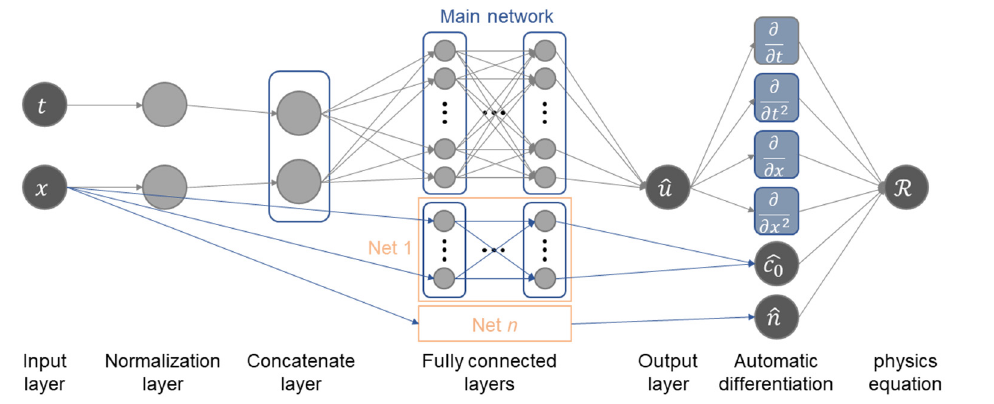
Figure 4. The architecture of the physics ‐ informed neural network considering the inhomogeneous material case. The model consists of multiple fully connected layers (main network and subnetworks). The main network is used to predict the output values, and the subnetworks (indicated as ‘Net n’) are used to predict coefficients of the embedded wave equation. The number of subnetworks depends on the number of coefficients